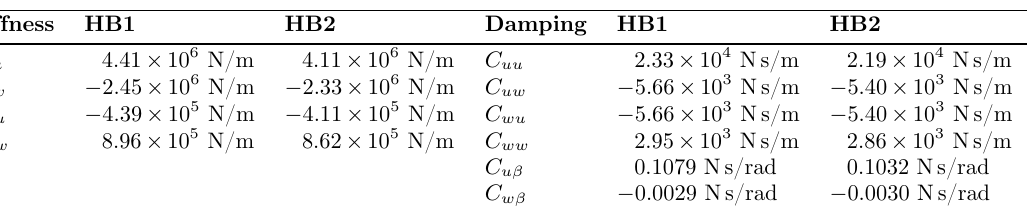
Table 3. Non-zero coefficients of the linearized stiffness and damping matrices of the hydrodynamic bearings at ˙ φ ∗ = 1700 rpm.